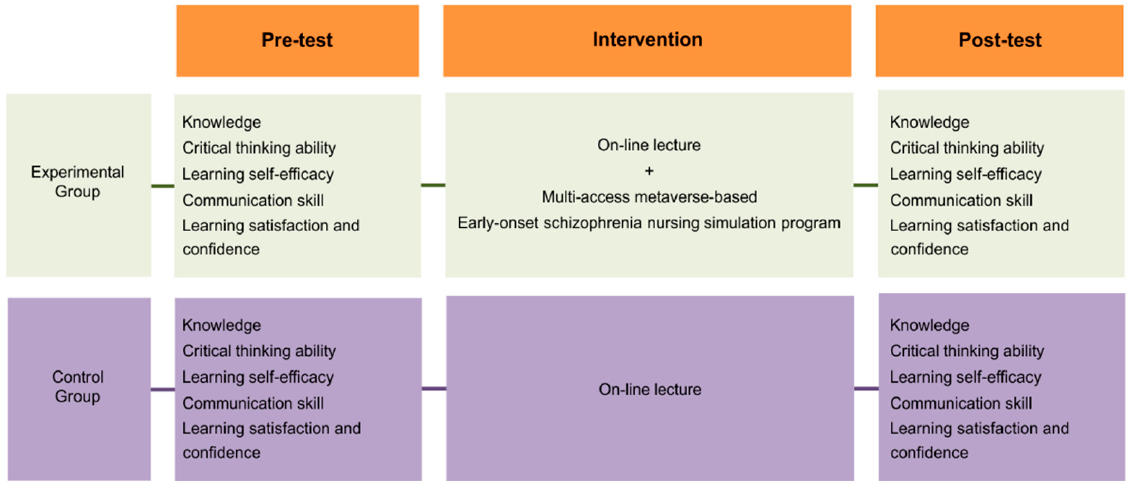
Figure 1. Research design. The online lecture includes the following topics: characteristics and major symptoms of patients with early onset schizophrenia (25 min), treatment and intervention methods for patients with early onset schizophrenia (25 min), therapeutic communication strategies for patients with early onset schizophrenia and their caregivers (listening, open-ended questions, restatement, clarification, reflection, focusing, sharing perceptions, identifying topics, silence, humor, the provision of information, suggestions, and confrontation; 50 min) through the online Learning Management System.